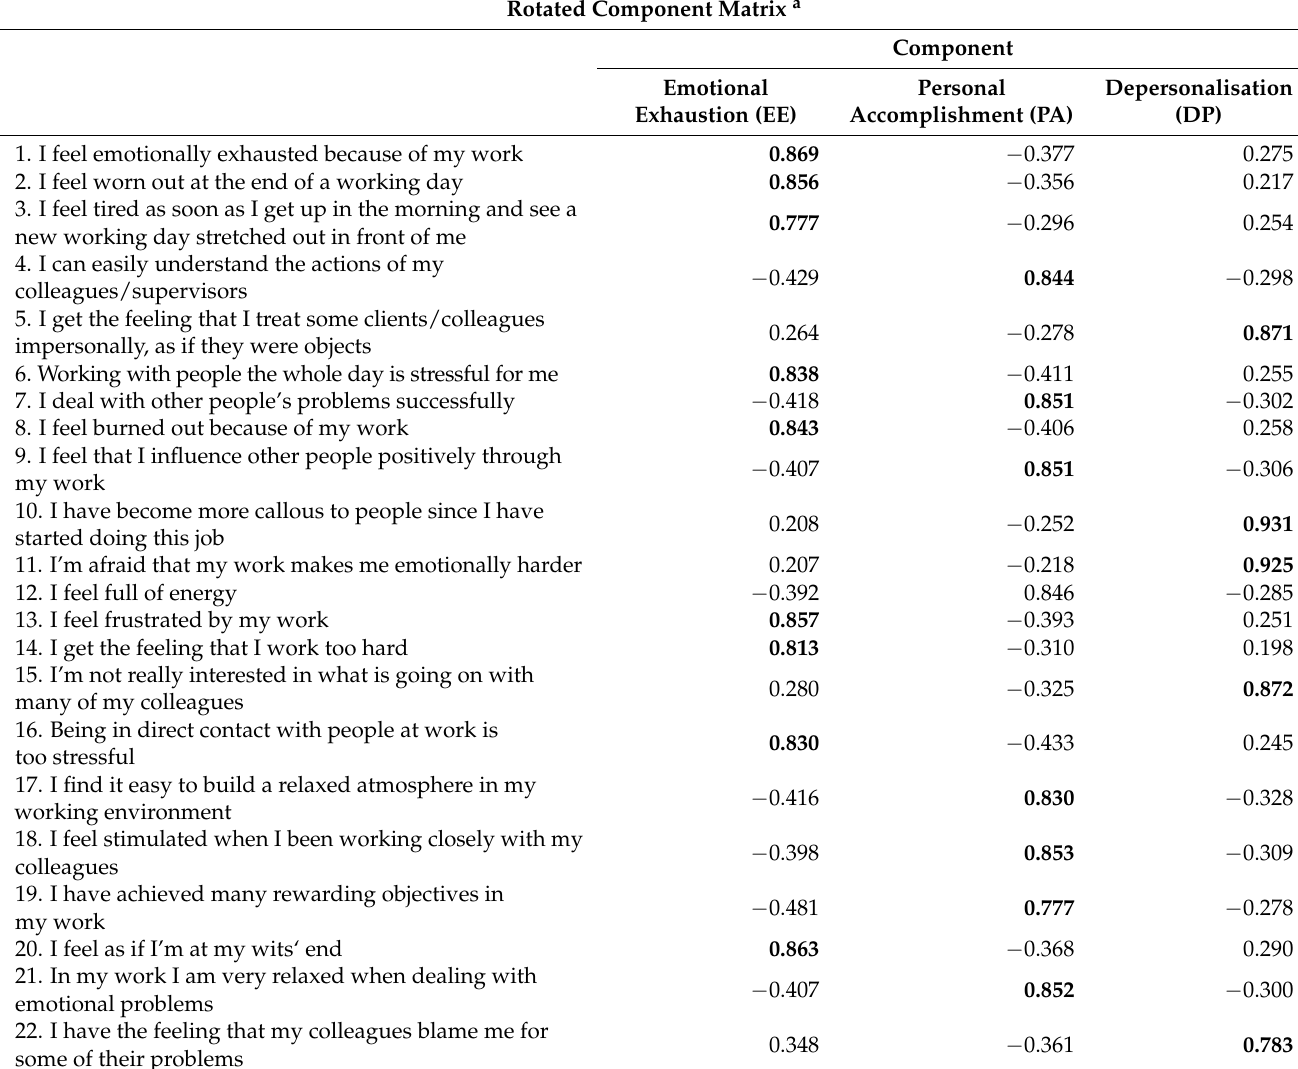
Table 2. Results of exploratory factor analysis of the Maslach Burnout Inventory —Human Services Survey ( MBI - HSS ) items (N =